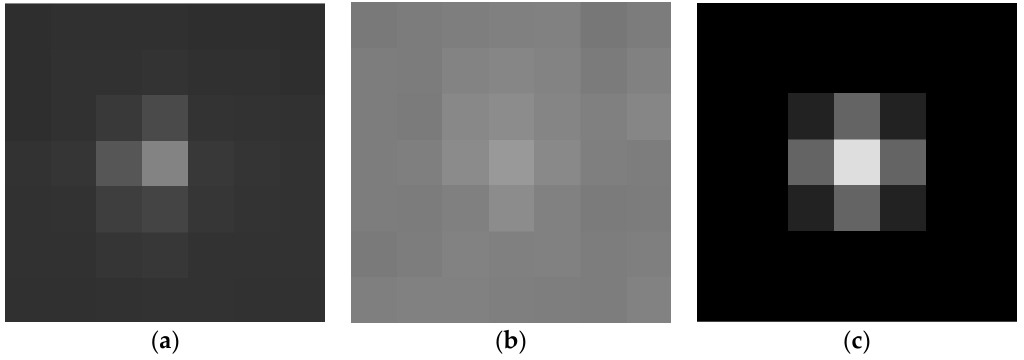
Figure 8. ( a ) Point source target image, ( b ) nonpoint source target image, and ( c ) common matching template of ( a ) and ( b ).